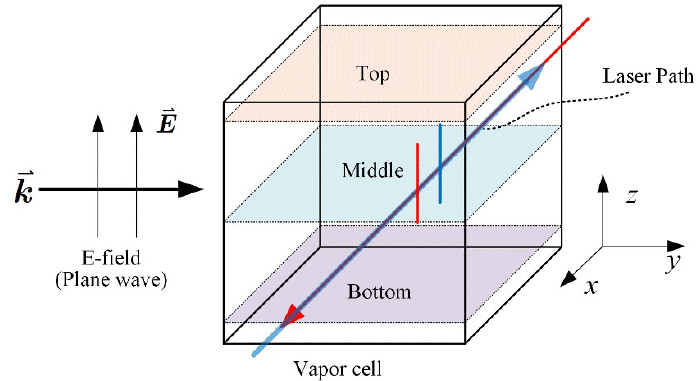
Figure 10. The simulation model for investigating the polarization distortion inside a cuboidal vapor cell, where the propagation ( k ) and polarization ( E ) of the RF E-field and lasers are illustrated with a systematic coordinate. The calculation focused on the three typical layers located at the top, middle, and bottom of the vapor cell.